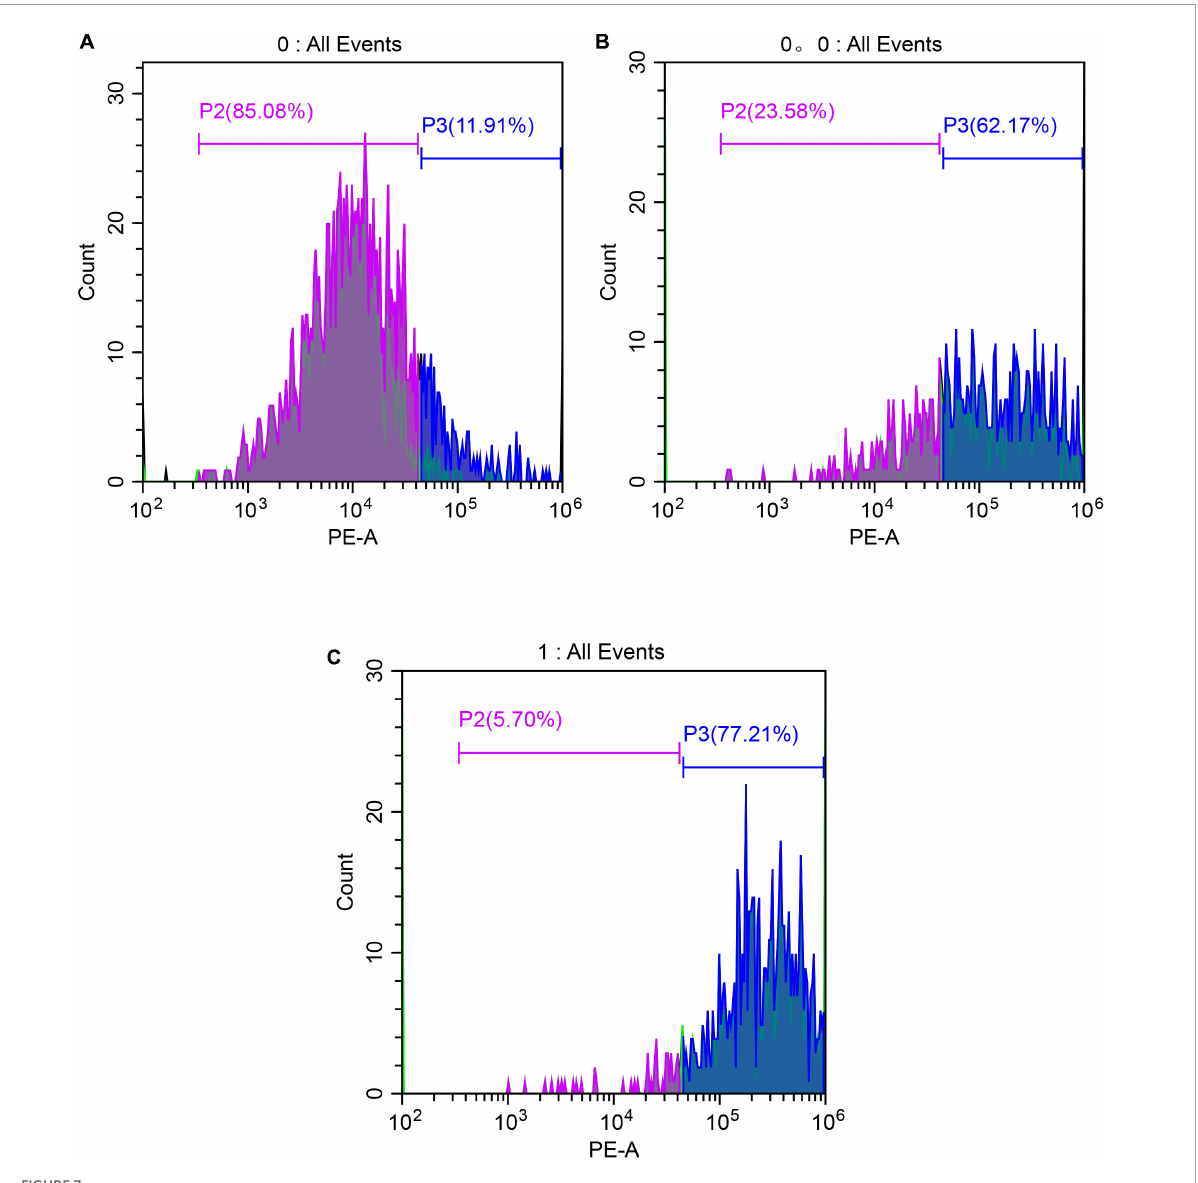
FIGURE7 Images of Staphylococcus aureus treated with anthocyanin (respective MIC and 2 MIC) by FCM. (A) Is the control group; (B) is the anthocyanin (MIC)-treated group; (C) is the anthocyanin (2 MIC)-treated group.